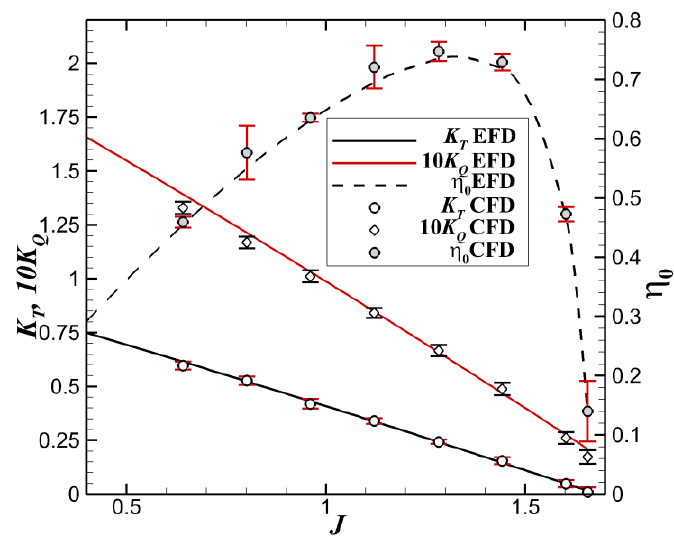
Figure 4. Propeller performance diagrams. Comparison between the numerical solutions and experimental data provided in [36].